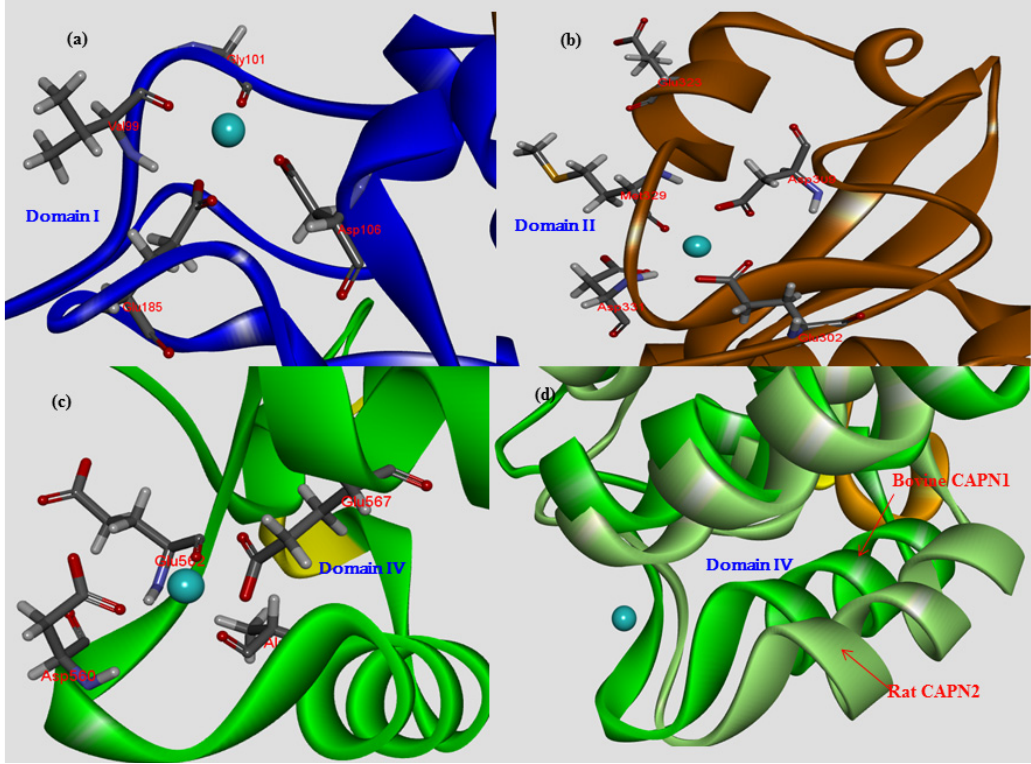
Figure 6. Three conserved Ca 2+ binding sites in the bovine CAPN1: ( a ) the loop in DI provides Ca 2+ -chelating residue side-chains of Asp106 and Glu185 and the backbone oxygens of Val99 and Gly101; ( b ) the second loop of the Ca 2+ -binding site in DII made by the side chain of Asp309, Glu302, the backbone oxygens of Glu333 and Met329, and the backbone nitrogen of Asp331; ( c ) The loop region of EF-hands has several acidic residues (Glu562, Asp560, and Glu567) and the backbone oxygen of Ala557 that help coordinate the Ca 2+ ion; ( d ) Ca 2+ binding to EF-hands in DIV, not only an equivalent location but also conserved binding pattern ADEE for both sub-groups (CAPN1 and